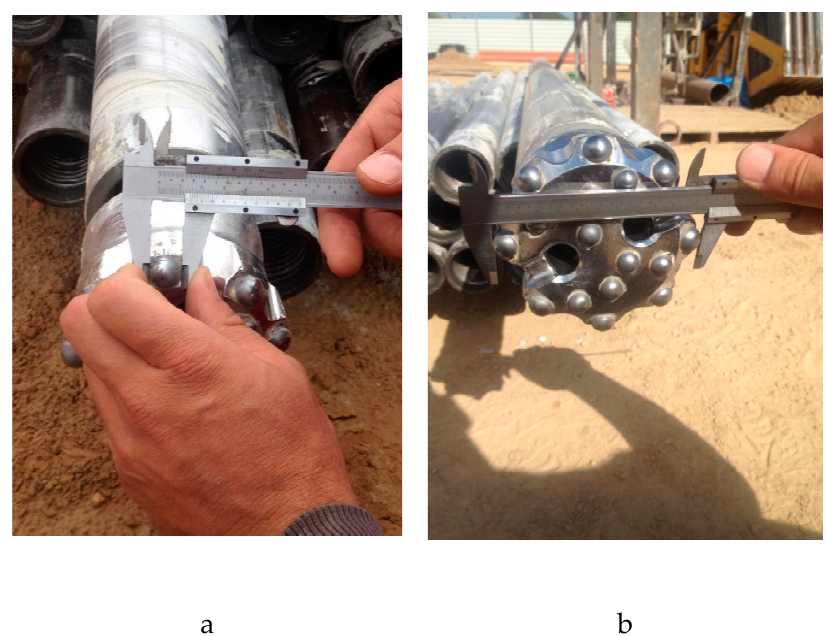
Figure 2. 110 mm drill bit being measured after the borehole section from 54 to 72 m below ground surface was drilled (photo by authors), a) measurement of single drill bit tooth, b) control of drill bit diameter.